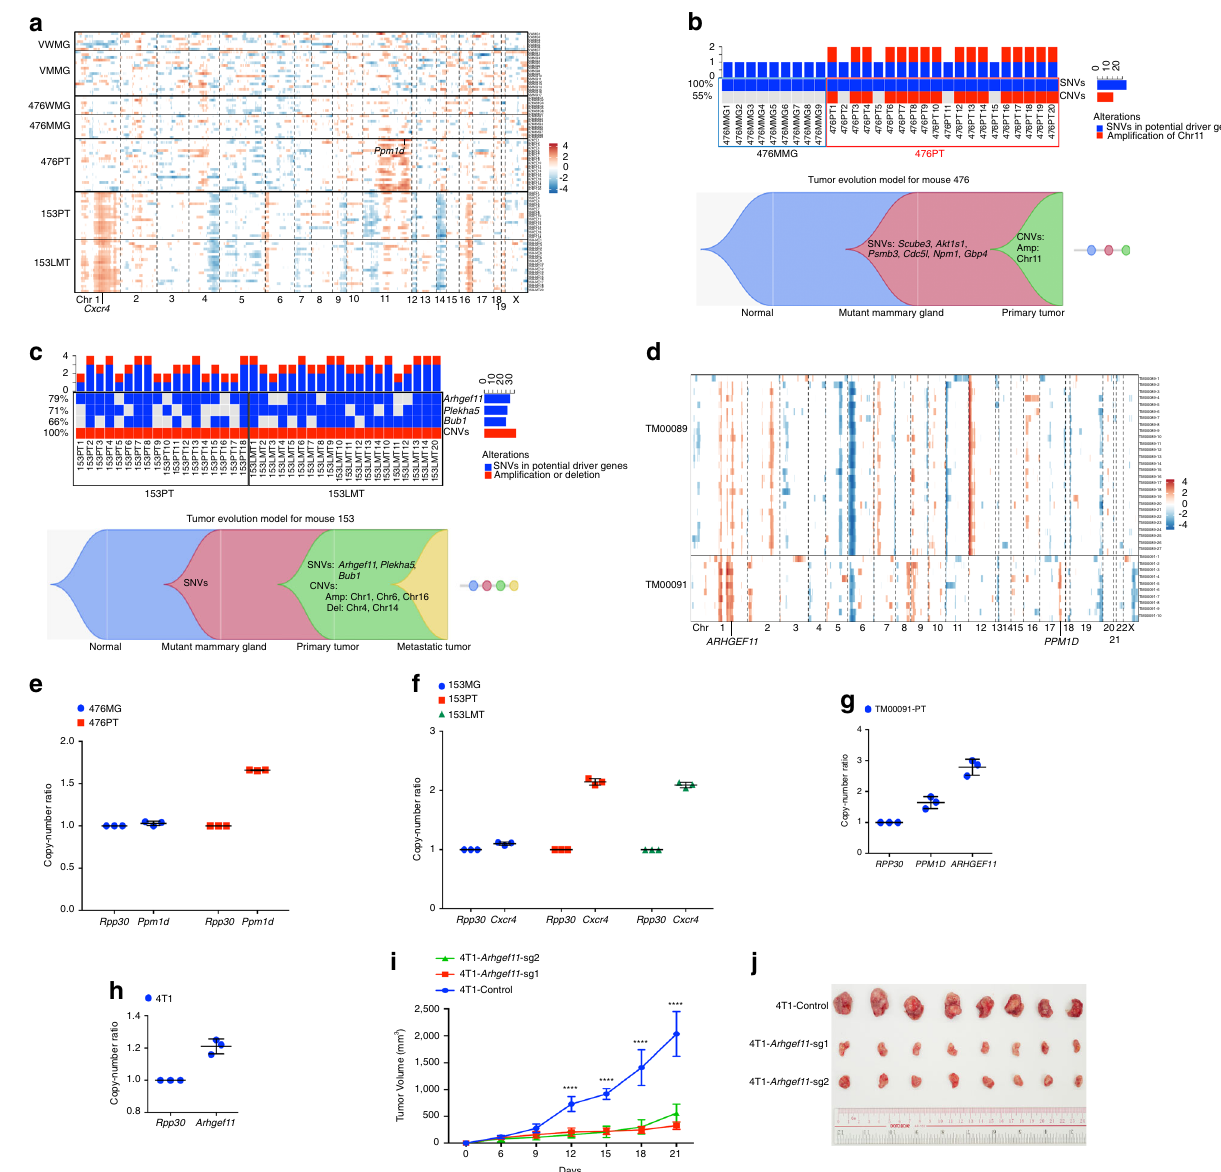
Fig. 5 Driver events of CNVs and tumor evolution of Brca1 -de fi cient breast tumor revealed by scWES. a DNA copy-number pro fi les based on the developmental stages of single cells from mice ( n = 98 cells). VWMG-virgin wild-type mammary gland cells from 4-month-old mouse; 476WMG-476 wild-type mammary gland cell from 11-month-old tumor-bearing mouse #476. b Top: oncoplot summarizing SNVs in potential driver genes ( Scube3 , Akt1s1 , Psmb3 , Cdc5l , Npm1 , etc.) (Fig. 4b; Supplementary Fig. 4b) and potential driver CNVs (ampli fi cation of chromosome 11) ( a ) of mouse 476. Bottom: tumor evolution model of mouse 476 based on potential driver SNV and CNV results. c Top: oncoplot summarizing SNVs in potential driver genes ( Arhegf11 , Plekha5 , Bub1 , etc.) (Fig. 4b; Supplementary Fig. 4c) and potential driver CNVs (ampli fi cation of chromosome 1, 6, 16, and deletion of chromosome 4, 14) ( a ) of mouse 153. Bottom: tumor evolution model of mouse 153 based on potential driver SNV and CNV results. d DNA copy number pro fi les of single cells from the BRCA1 -MT PDX models ( n = 37 cells). TM00089, which carries a frameshift variant: BRCA1 -V757fs; and TM00091, which carries a common pathogenic missense variant C61G in BRCA1 RING domain. e – h ddPCR analysis of ampli fi cation of chromosome 11 ( Ppm1d ) in 476MG and 476PT ( e ), ampli fi cation of chromosome 1 ( Cxcr4 ) in 153MG and 153PT ( f ), ampli fi cation of chromosome 1 ( ARHGEF11 ) and chromosome 17 ( PPM1D ) in TM00091 ( g ), ampli fi cation of Arhgef11 in 4T1 cell line ( h ). Rpp30 / RPP30 was used as a reference gene for normalization. Three technical replicates were performed. i Measurement of tumor volume after implantation of 4T1 Control and 4T1- Arhgef11 -KO cells into mammary fat pat (4 × 10 6 tumor cells per injection, n = 8 mice per group). Data are reported as the mean ± SD with two-way ANOVA analysis with Dunnett ’ s test, **** P < 0.0001. j Image of tumors in ( i ) at the endpoint of measurement. Error bars represent Ppm1d might play a role in suppressing p53 and driving tumor formation and metastasis, including cell survival, proliferation, formation in this scenario. The oncogene Cxcr4 was found in the adhesion, migration, and invasion 53 . Besides, several TSGs, including E2f2 , Wnt5a , and Bmp8b , etc. were found in the ampli fi ed region of chromosomes 1 in 153PT and 153LMT cells deleted regions of chromosomes 4 and 14 in 153PT and (Fig. 5a; Supplementary Fig. 5k). Cxcr4 has been reported to be 153LMT cells (Fig. 5a; Supplementary Fig. 5l). These data are involved in many important processes surrounding tumor